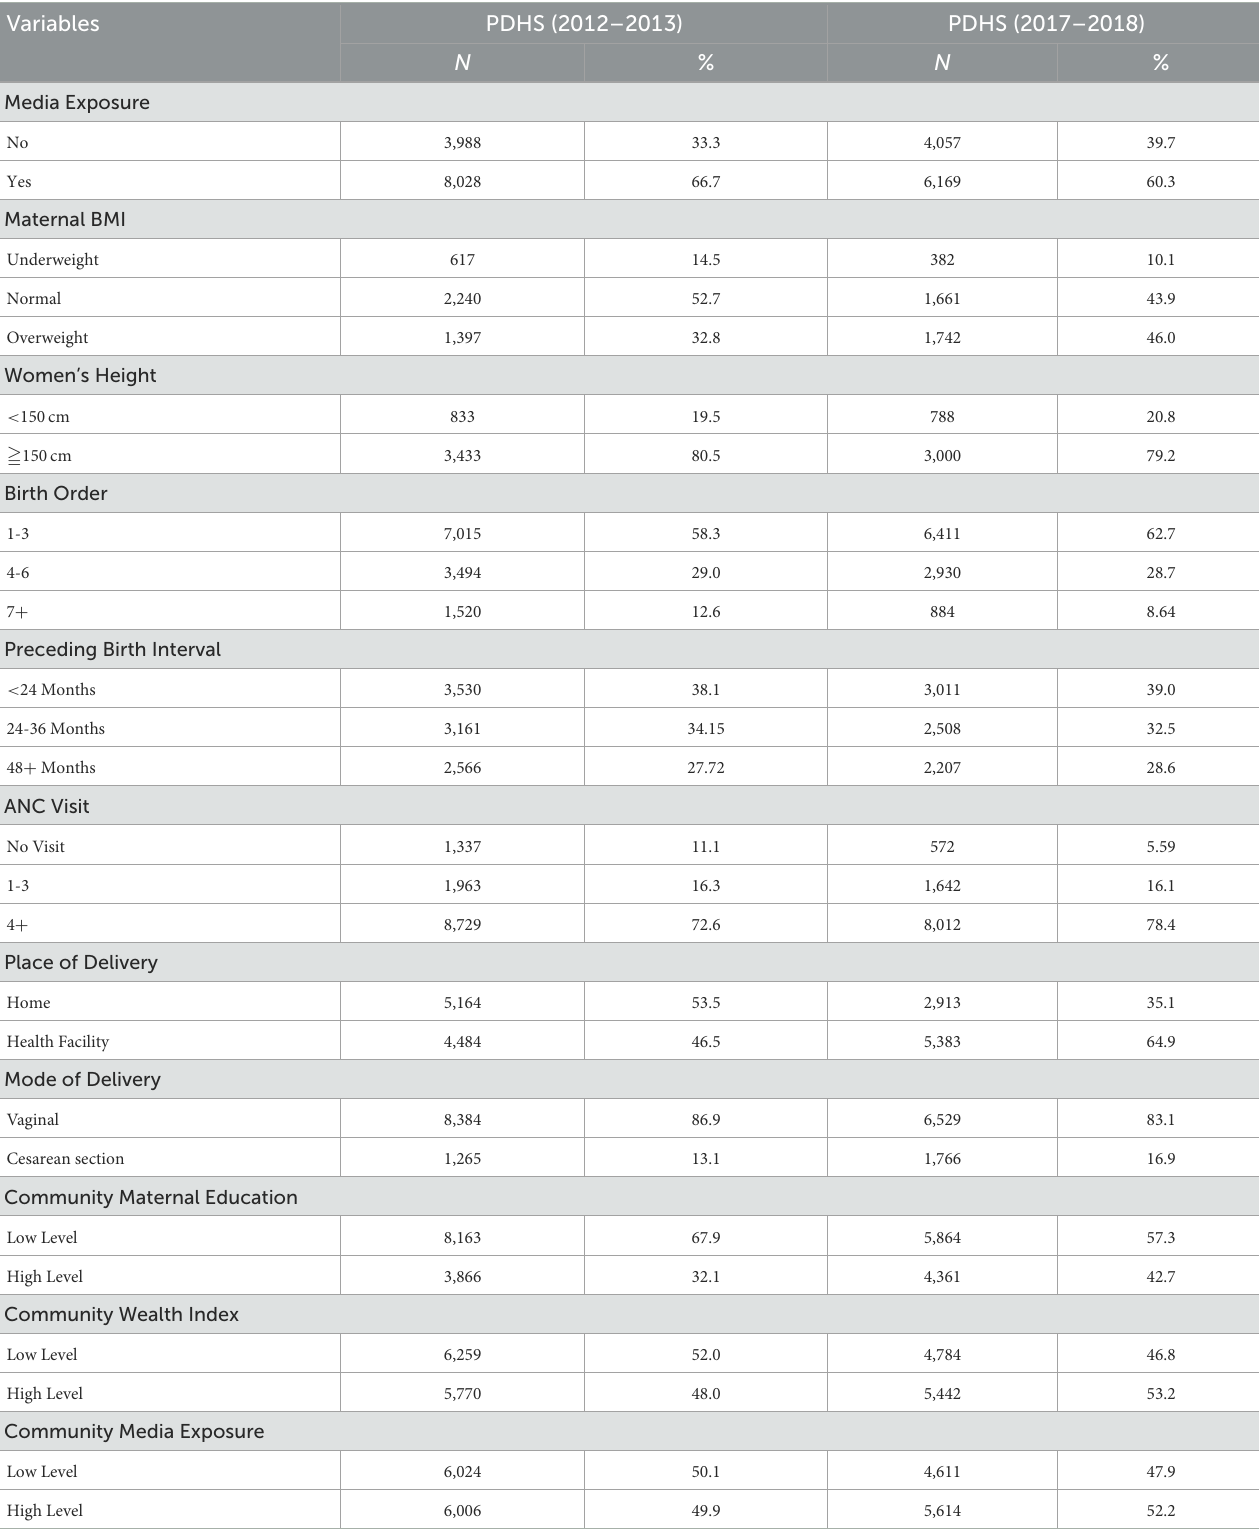
TABLE 2 Labor, Delivery Care and Other Characteristics of Ever Married Women who had given birth within 5 years before survey in Pakistan, PDHS from 2012 to 2013 and from 2017 to